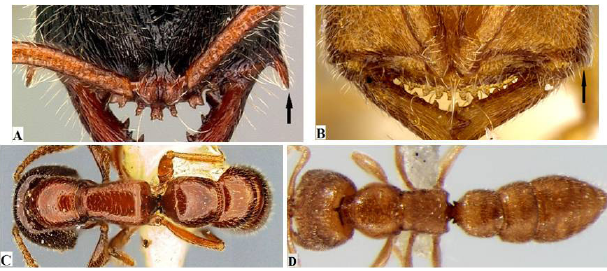
Figs A-D. S . falcatum (Lattke, 1991). A. Anterolateral corners of head acutely toothed; B. Anterolateral corners of head not toothed; C. Mesosoma smooth and shiny; D. Mesosoma variously sculptured from sparsely to densely punctuate.